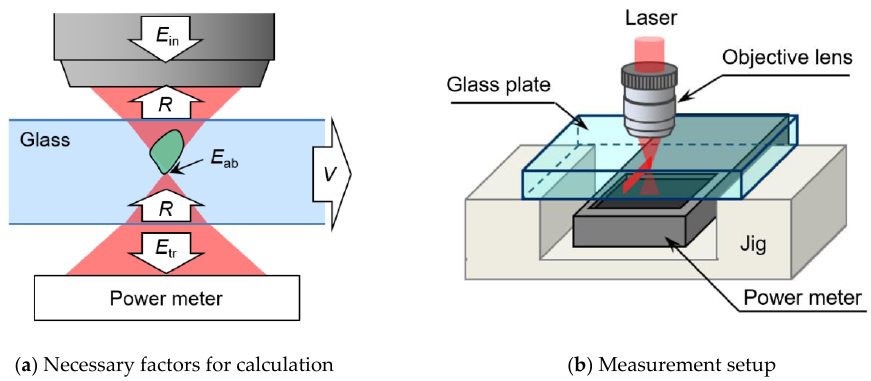
Figure 5. Schematic illustration of calculation and measurement method of absorption rate.